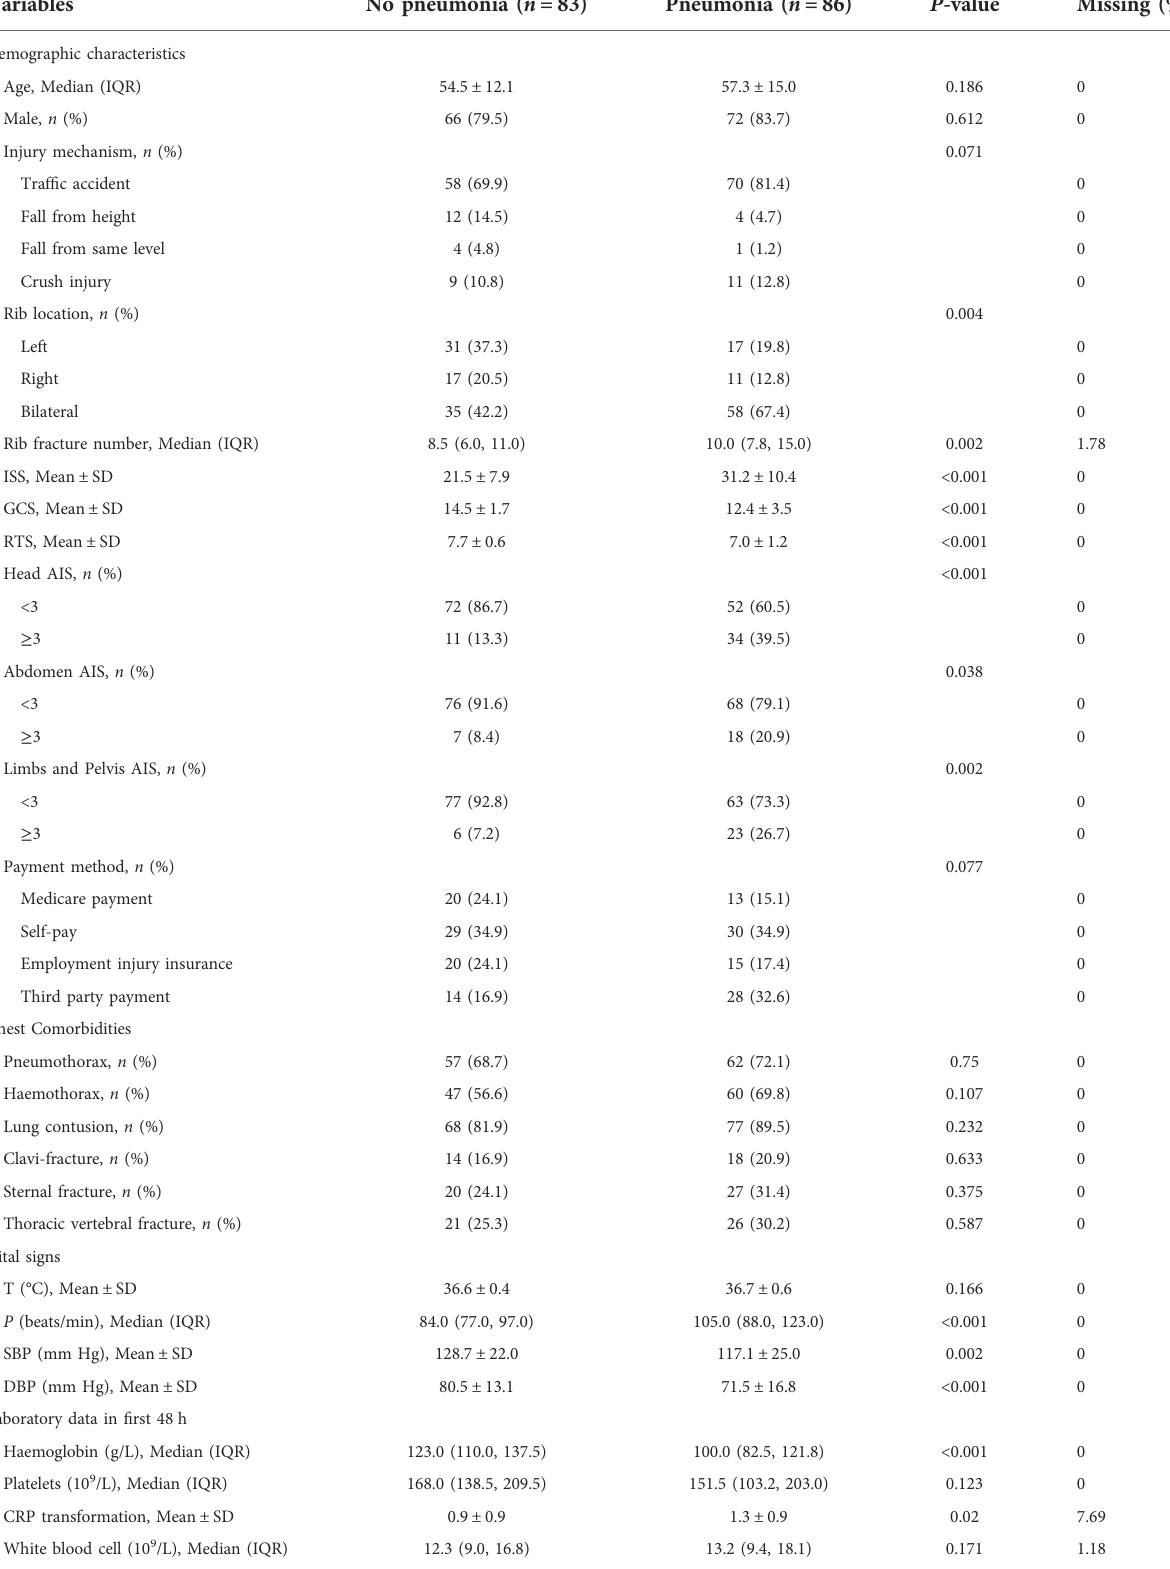
TABLE 1 Baseline characteristics of patients by clinical